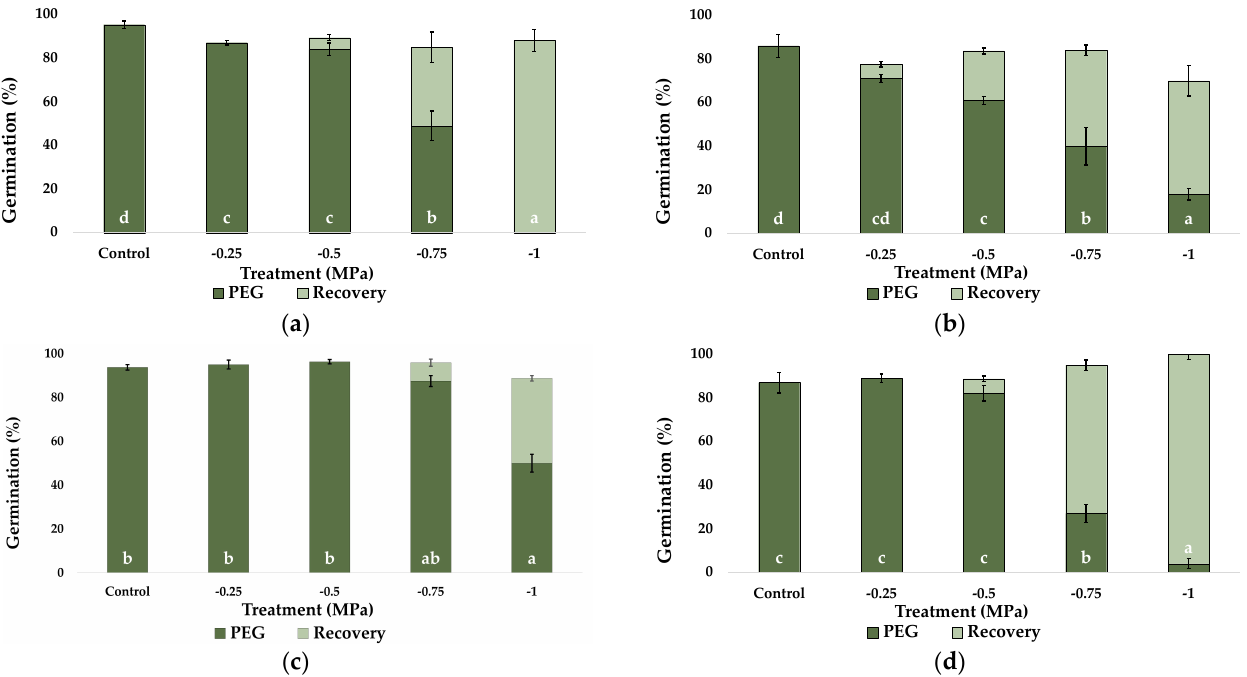
Figure 3. Final germination percentages after 30 days under increasing concentrations of PEG, as indicated (dark green), and germination recovery percentages, 20 days after transferring previously stressed, not germinated seeds to control conditions (light green) for: ( a ) C. citratus , ( b ) C. selloana , ( c ) P. alopecuroides , and ( d ) P. setaceum . Control: germination in distilled water. Values shown are means ± SE ( n = 4). Different lowercase letters within the bars indicate significant differences between treatments, for each species, according to the Tukey post hoc test ( p < 0.05). The highest PEG concentration tested ( − 1 MPa) caused a complete ( C. citratus ) or very strong (down to 4%, P. setaceum ) germination inhibition. These values decreased more progressively in C. selloana , from the control’s 86% to 70, 60, 40 and 20%, at − 0.25, − 0.5, − 0.75 and − 1 MPa, respectively (Figure 3b). The recovery ability of the seeds that failed to germinate in the presence of PEG was tested by placing them in new Petri dishes with distilled water for 20 days (Figure 3). Full recovery was observed in the four species, with final germination percentages equivalent to, or even exceeding, those registered in the control treatments. For instance, in P. seta ‐ ceum , the recovery treatment of − 0.75 MPa and − 1 MPa stressed seeds resulted in final germination percentages of 93 and 96%, respectively, compared to 87% in the control (Fig ‐ ure 3d). Mean germination time (MGT) was calculated during the stress and subsequent re ‐ covery assays (Figure 4). Overall, MGT increased with increasing PEG concentrations. In C. citratus and both Pennisetum species, MGT rose progressively in the initial germination assays; in the recovery assays, for all previously stressed seeds, germination time was very short once optimal conditions were restored (Figure 4a,c,d). On the other hand, C. selloana seeds showed a somewhat different pattern, with a significant MGT increase at − 0.5 MPa, which did not vary at higher PEG concentrations; in this case, MGT in the recovery treat ‐ ments were also lower than in the corresponding stress treatments, except for the seeds that did not germinate in the presence of PEG at − 0.25 MPa (Figure 4b). ( a )